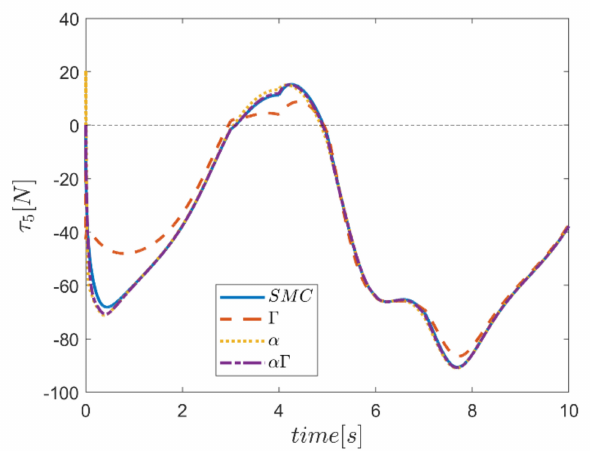
Figure 32. Comparison of the input force in the fifth